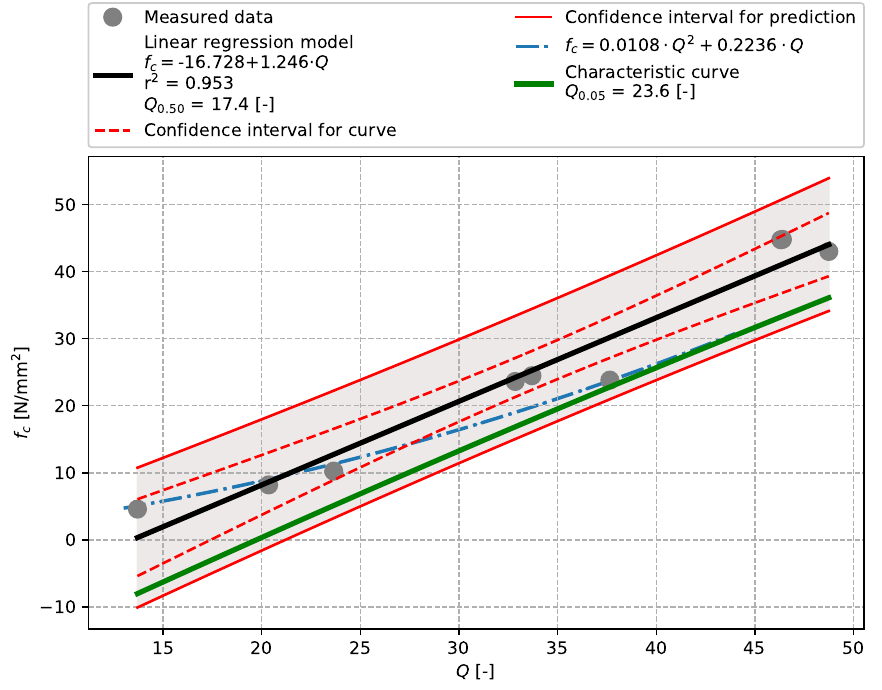
Figure 10. Precast concrete described in Section 3.2—model of the dependence of Q -value [-] vs. compressive strength f c [N/mm 2 ]—SilverSchmidt